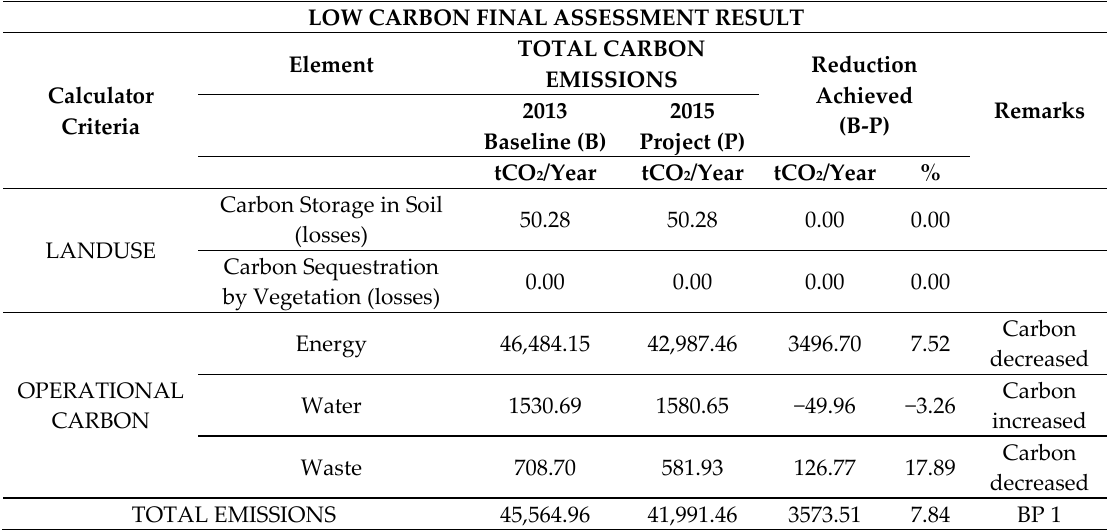
Table 1. UTM LCCF